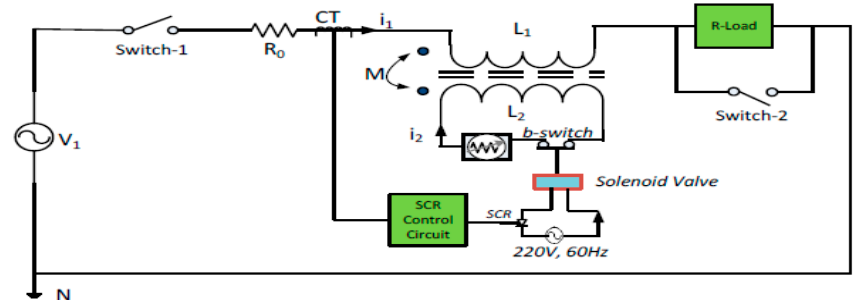
Figure 11. Diagram of transformer type SCFCL in single line circuit.